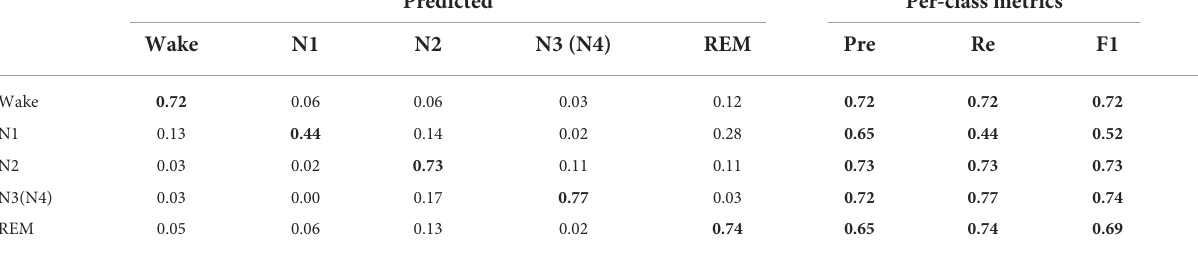
TABLE 4 Confusion matrix for each stage before data